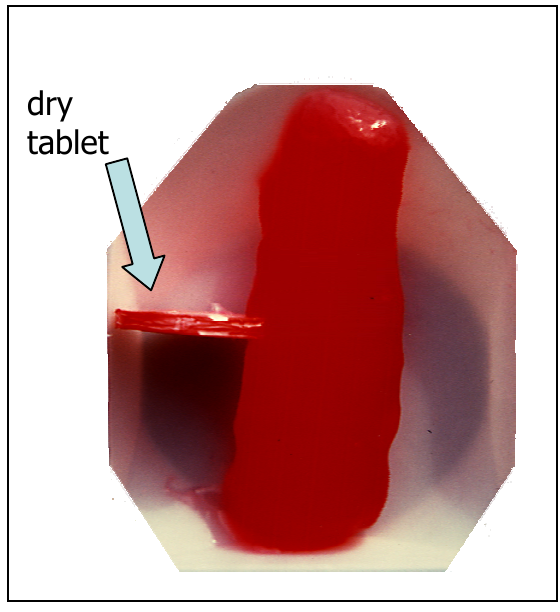
Figure 16. Picture of a tablet before (left) and after (right)